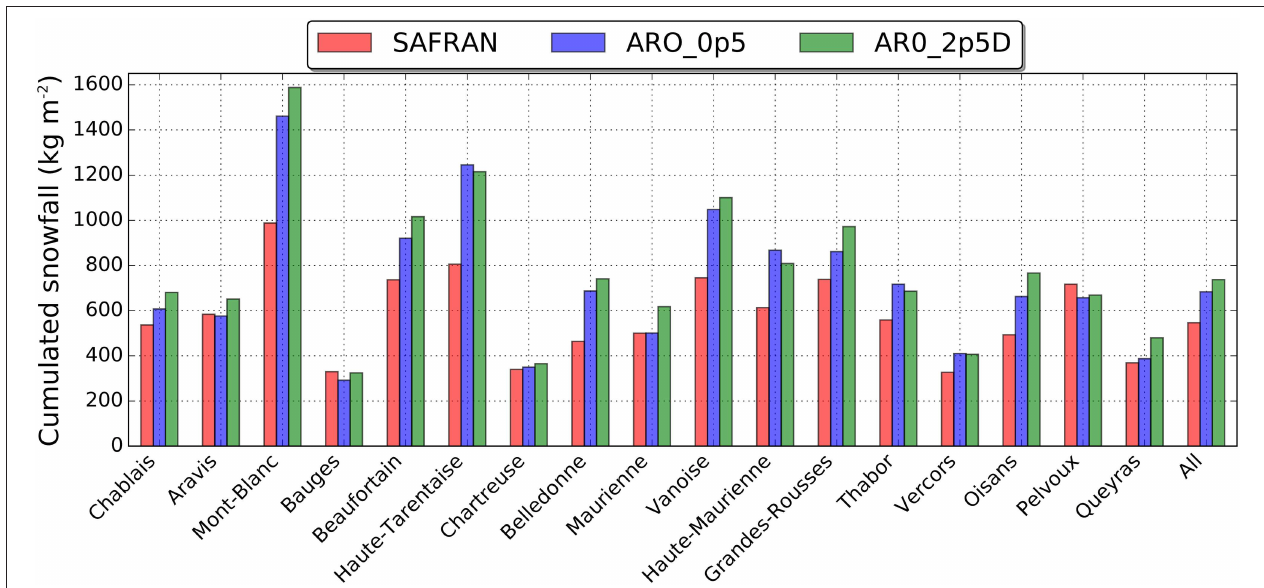
FIGURE 3 | Total snowfall from September 1st 2011 to June 30th 2012 averaged over the massifs shown on Figure 1 for the three precipitation datasets. All refer to the total snowfall for all the massifs. The massifs are ordered from North to South as on Figure 1 .